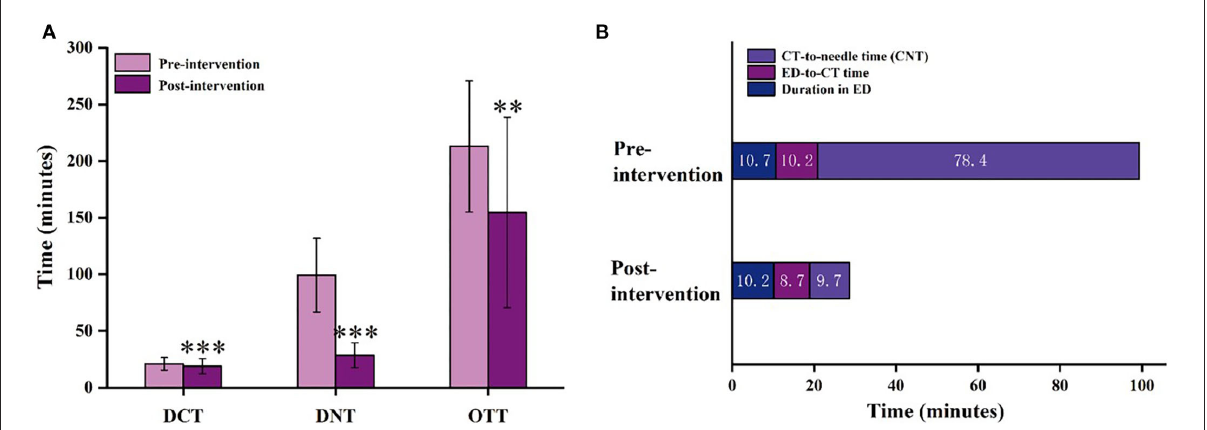
FIGURE3 The time intervals for AIS patients with intravenous thrombolysis in the pre-intervention and post-intervention groups. (A) DCT, DNT, and OTT of AIS patients with intravenous thrombolysis; (B) Three parts of the DNT (a. Duration in ED; b. ED-to-CT time; c. CT-to-needle time [CNT].) in the pre-intervention and post-intervention groups. DCT, door-to-CT time; DNT, door-to-needle time; OTT, onset-to-treatment time; CT, computed tomography; ED, emergency department. The data are expressed as the mean ± SD. ** p < 0.01, *** p < 0.001 vs. the pre-intervention group.